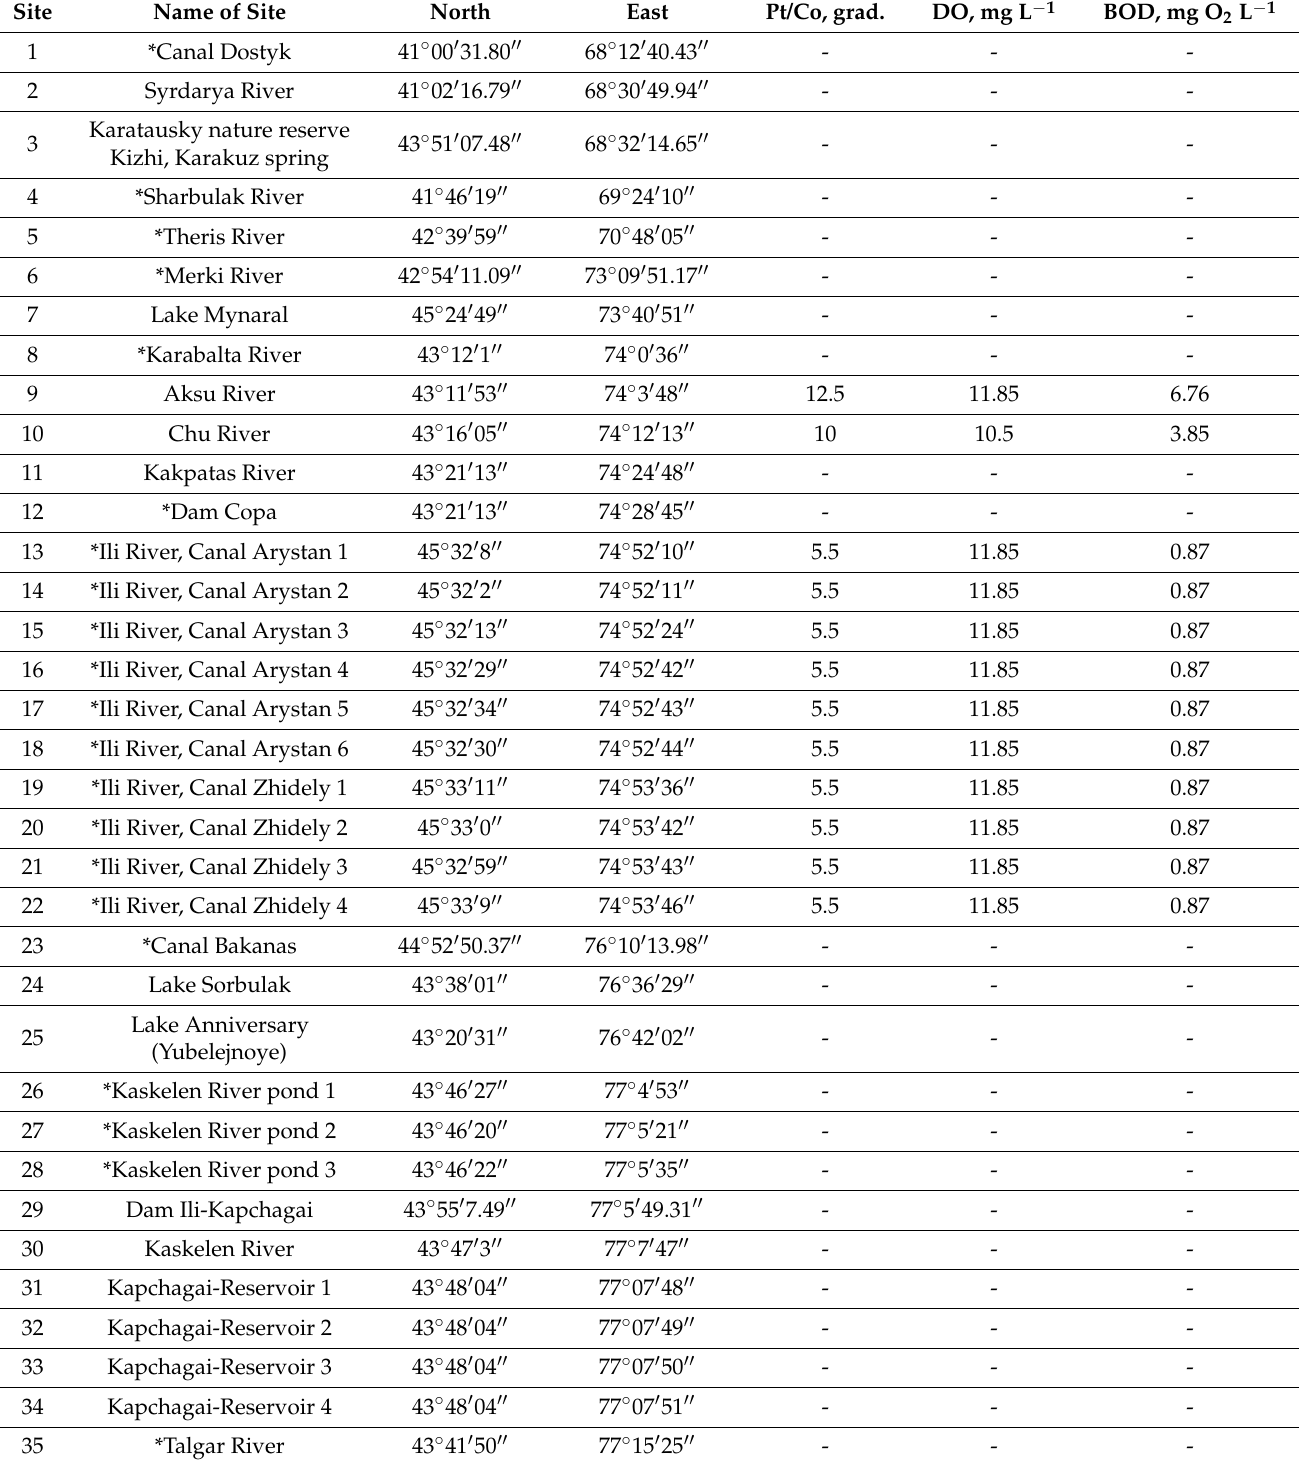
Table A1. Investigated sites coordinates and known environmental variables [8] of aquatic habitats in south and southeast Kazakhstan, 2019–2022. “*”, first investigated sites; “-“, no data. The environ- mental data is presented only for those 34 sites where complete environmental data were